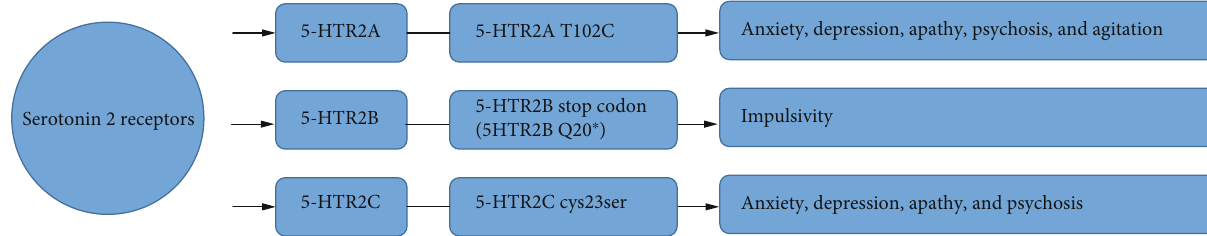
Figure 1: The relationship between 5-HT receptor subtypes and genotypes and